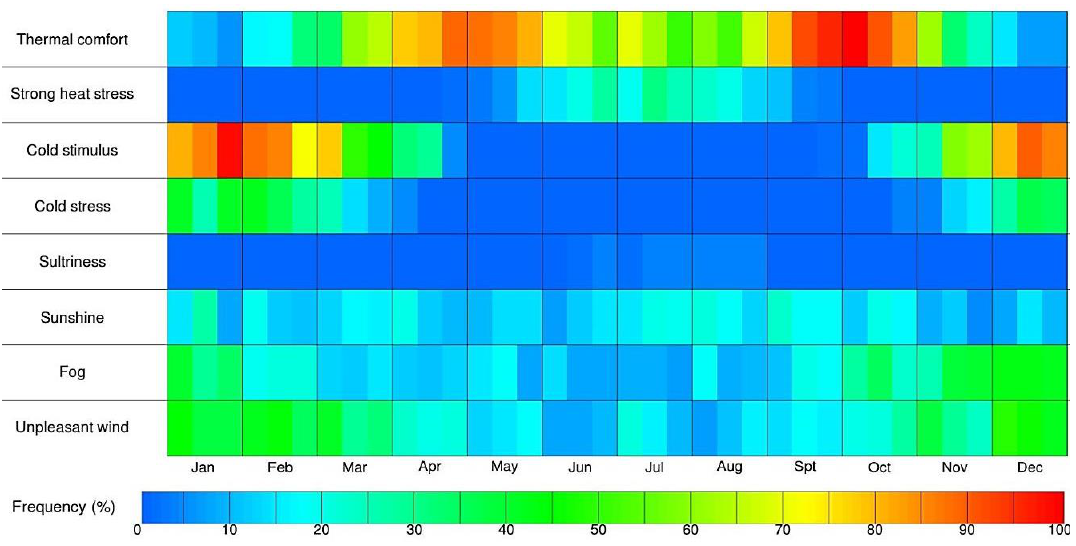
Figure 9. The CTIS of Hinterzarten, extracted from the AOI of southern Baden, averaged over the time period 1995–2012.